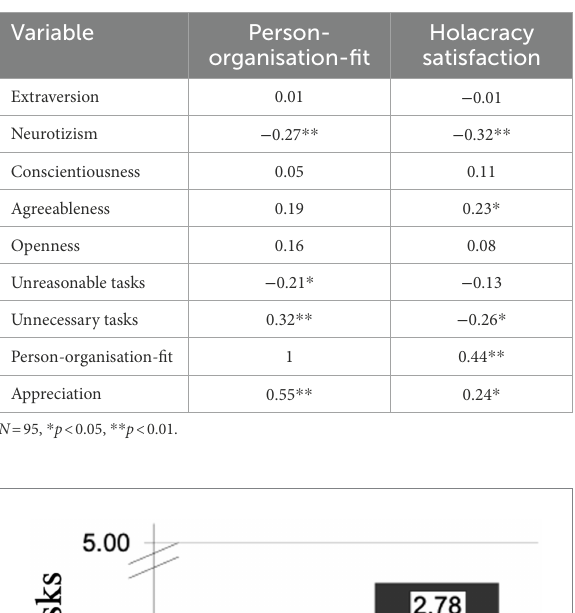
TABLE 3 Pearson correlations of person–organisation fit and holacracy satisfaction with personality traits.